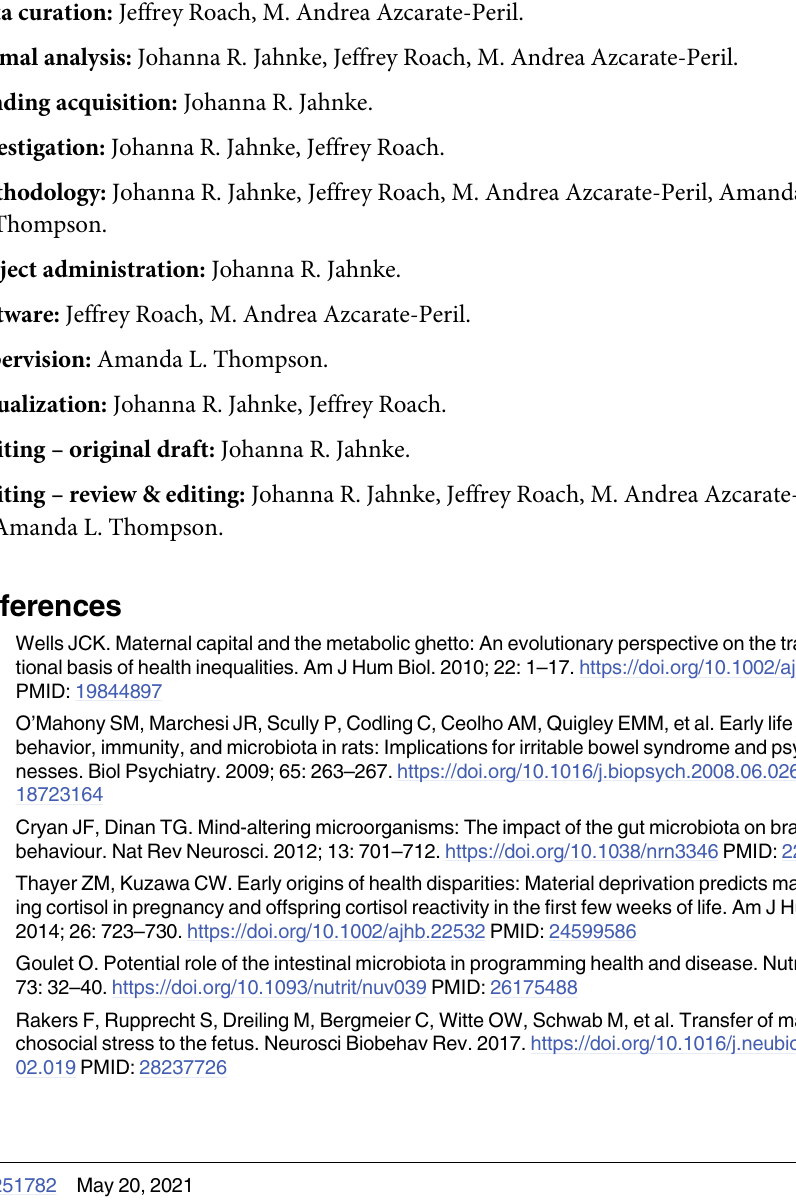
S1 Table. Correlations among precarity measures, represented as correlation coefficients ( r